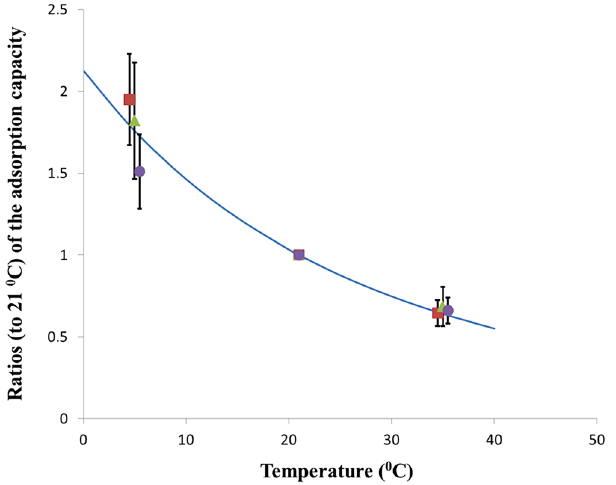
Figure 2. The temperature dependence of the adsorption capacity, illustrated by the experimental ratio CF 0 ( T ) / CF 0 (21 °C) (points) and theoretical k ( T ) / k (21 °C) (the curve), where k-values are calculated using Eq. (7). The experimental points are related to detectors with Kynol 507-10 ( ), ACC-10 ( ) and ACC-20 ( ). The points at 5 and 35 °C are slightly deflected horizontally, for better